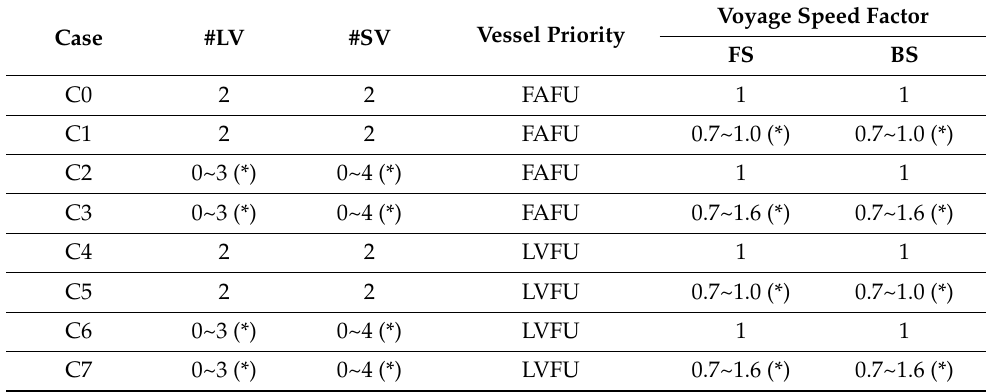
Table 2. Design of